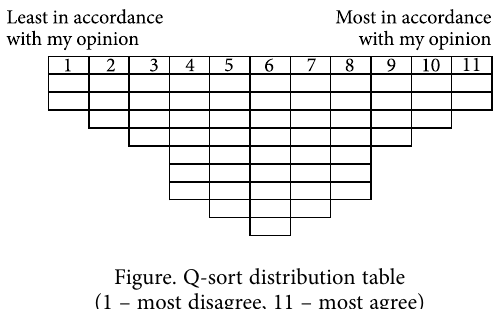
Figure. Q-sort distribution table